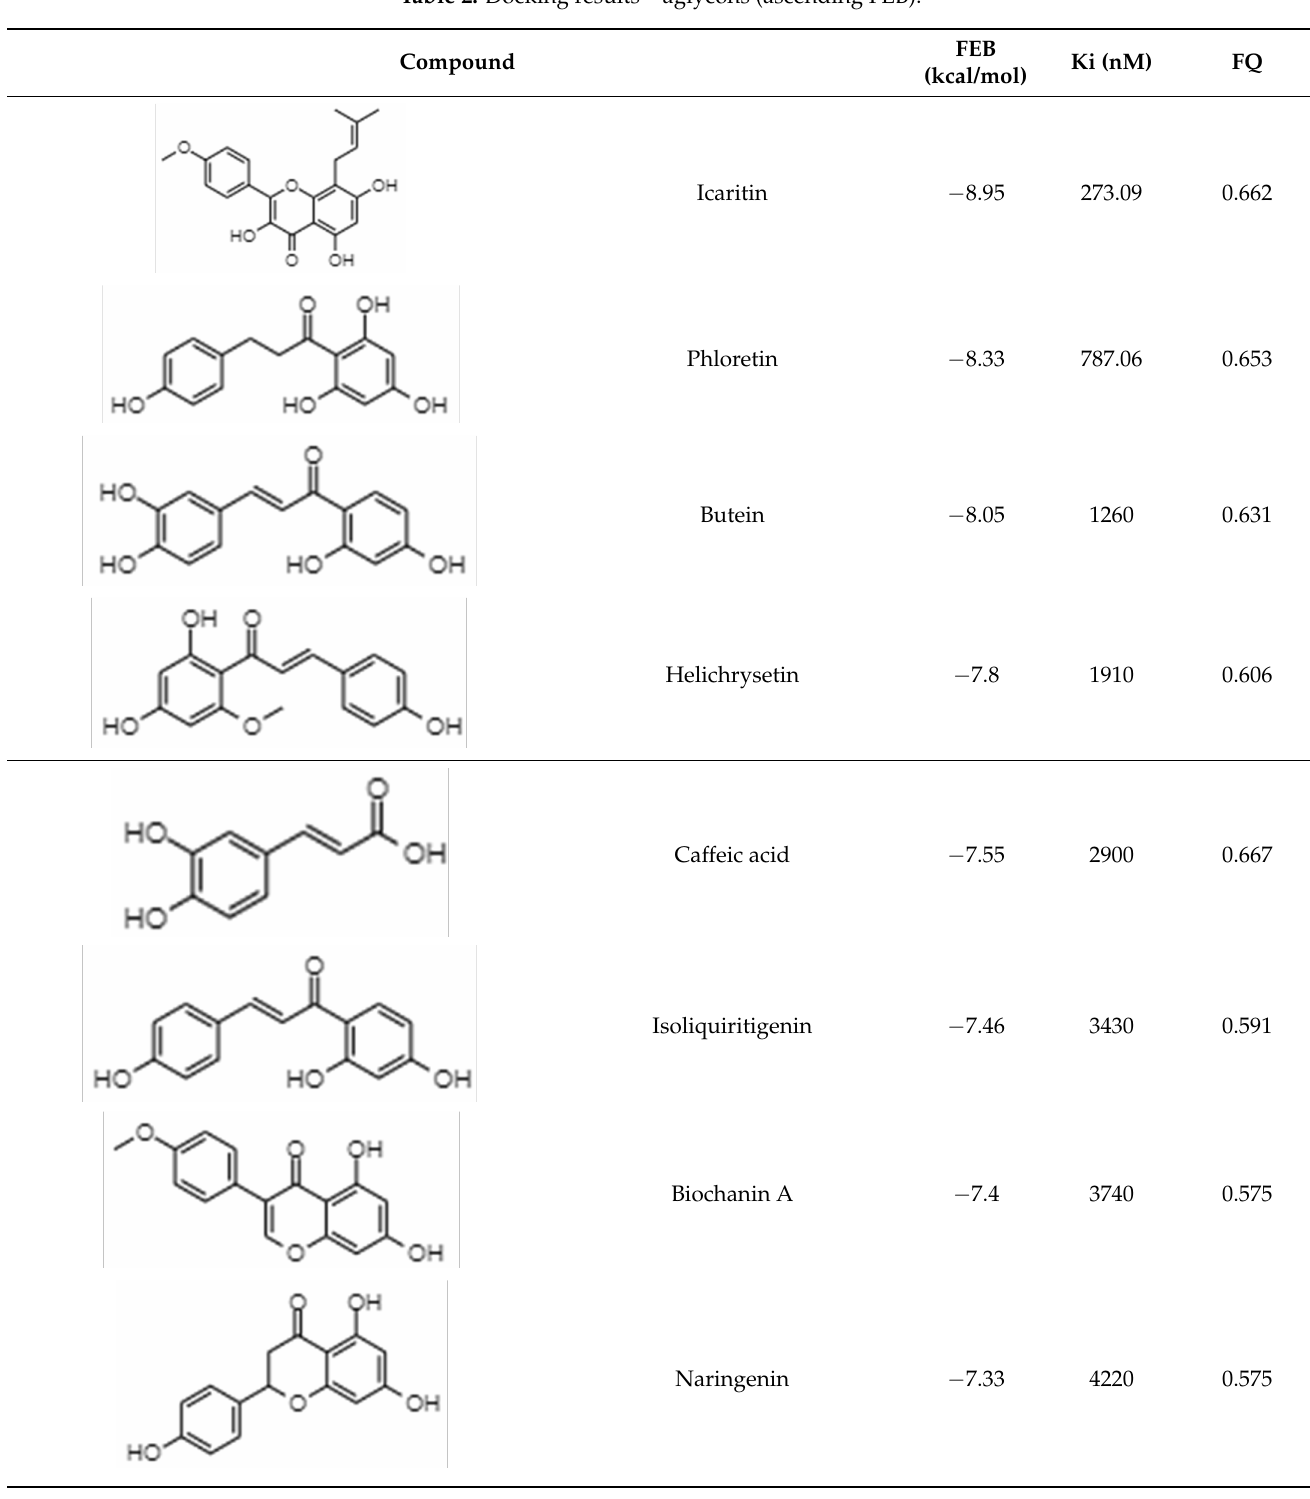
Table 2. Docking results—aglycons (ascending